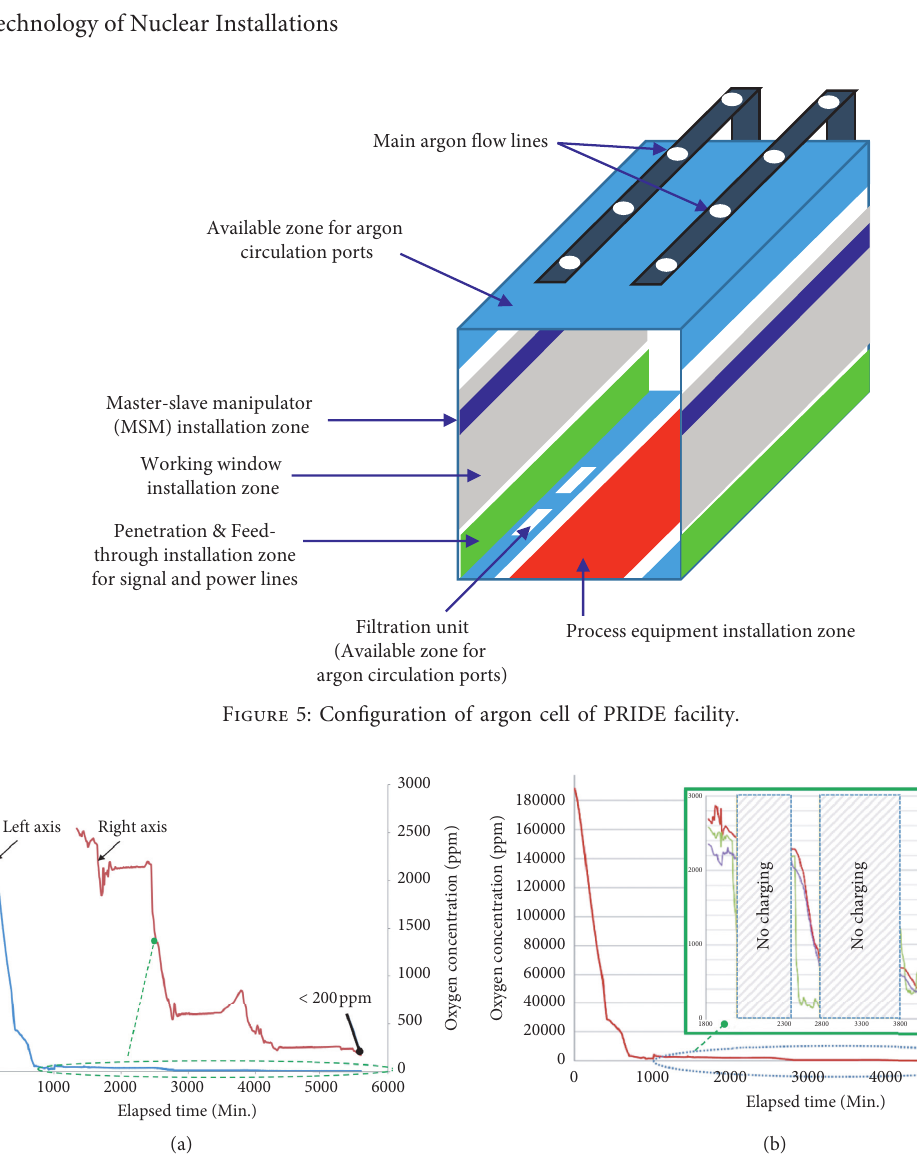
Figure 6: Experimental result of purging test for argon cell in PRIDE facility. (a) The result of purging test for argon cell in PRIDE facility. (b) Operational scheme of argon purging test for PRIDE (cycle purging method).